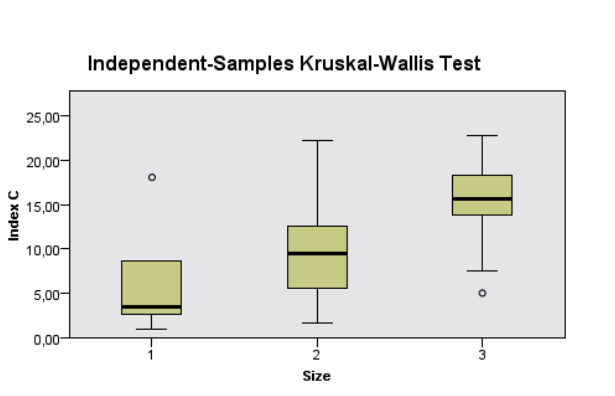
Fig. 2 – Kurskal-Wallis test. Source: own, IBM